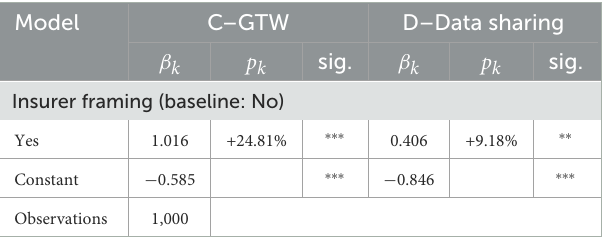
TABLE 10 Regression results for payer